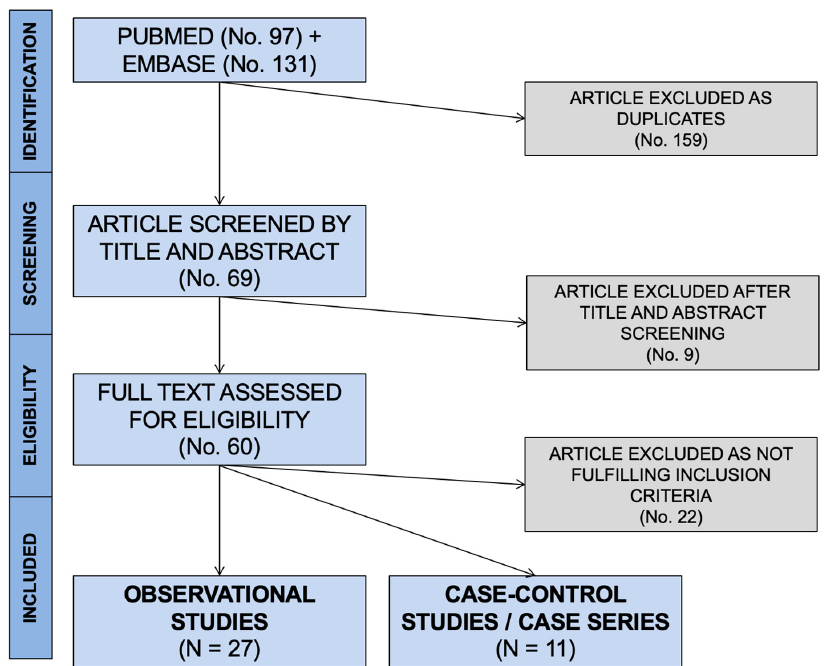
Figure 1. PRISMA flowchart for retrieved studies.